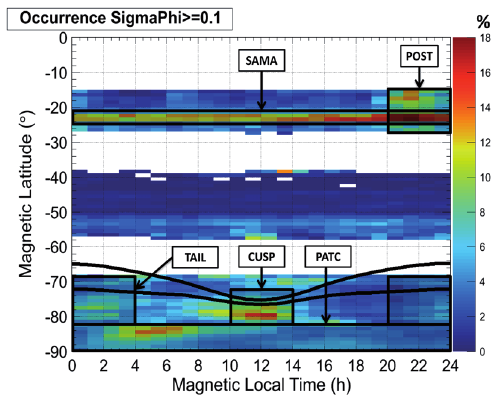
Figure 7. Map of v U percentage of occurrence above the weak scin- tillation threshold (0.1 radians). The black curve is the modeled Feldstein oval for IQ = 0, while the black boxes define the ionos- pheric hot